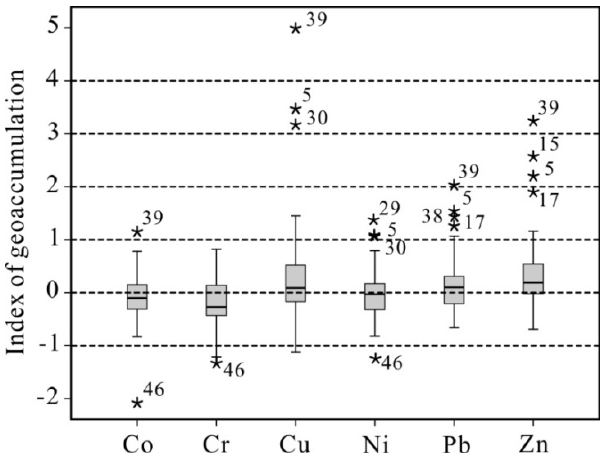
Figure 6. Boxplot of I s of heavy metals in the lake sediments collected from the middle g and lower reaches of Rangtze River. In this box plot, the horizontal line shows the mean values, the top and bottom of the box mark the limits of ±25% of the variable population, while the lines extending from the top and bottom of each box mark the minimum and maximum values that fall within 1.5 times the interquartile range below/above the 5th/95th s exceeding 1.5 times the width of the box. percentiles. The stars represent I g